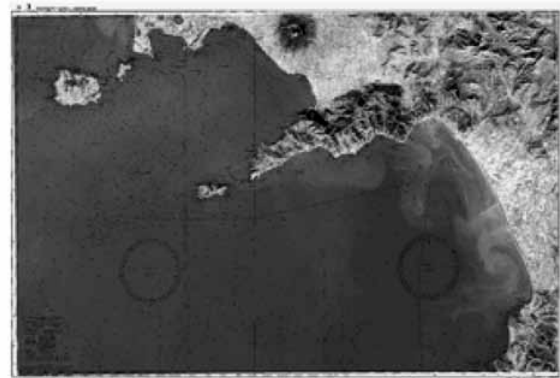
Fig. 7. The overlapping between the nautical chart and the Landsat 8